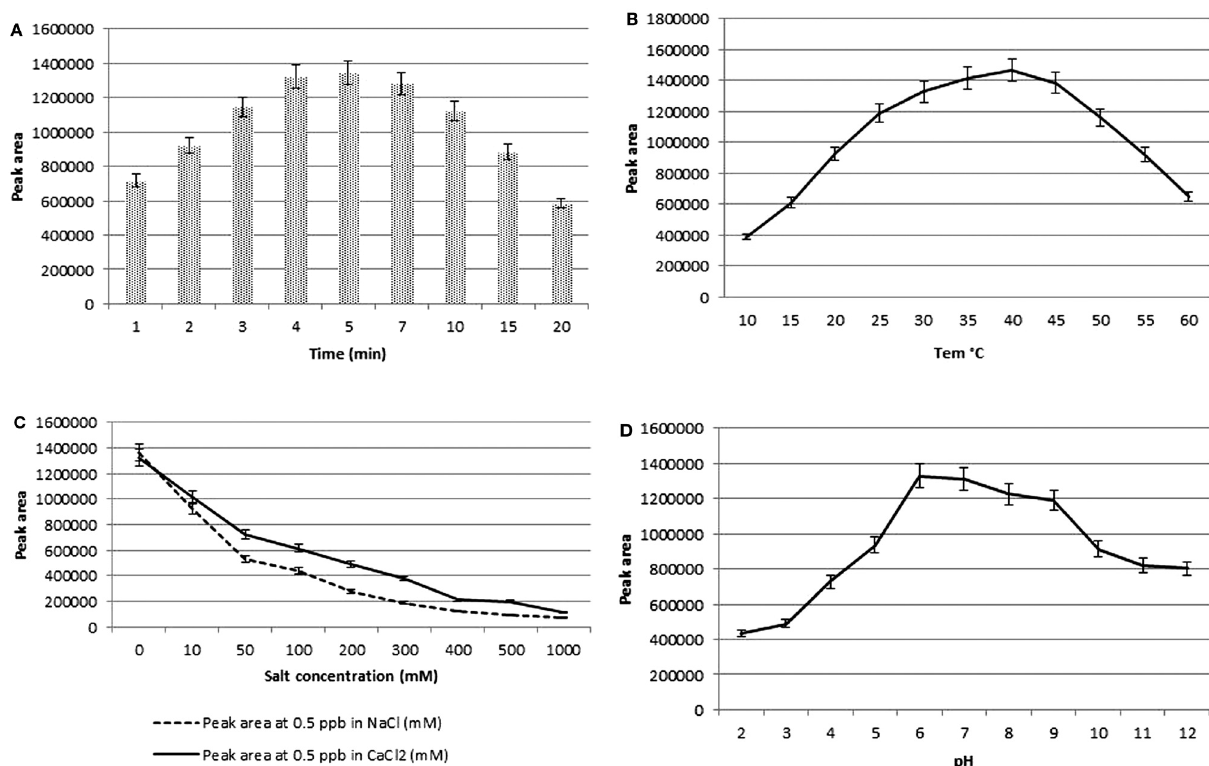
Figure 4: Effect of time (a), temperature (b), salts (c), and pH (d) on microextration efficiency of the SPME